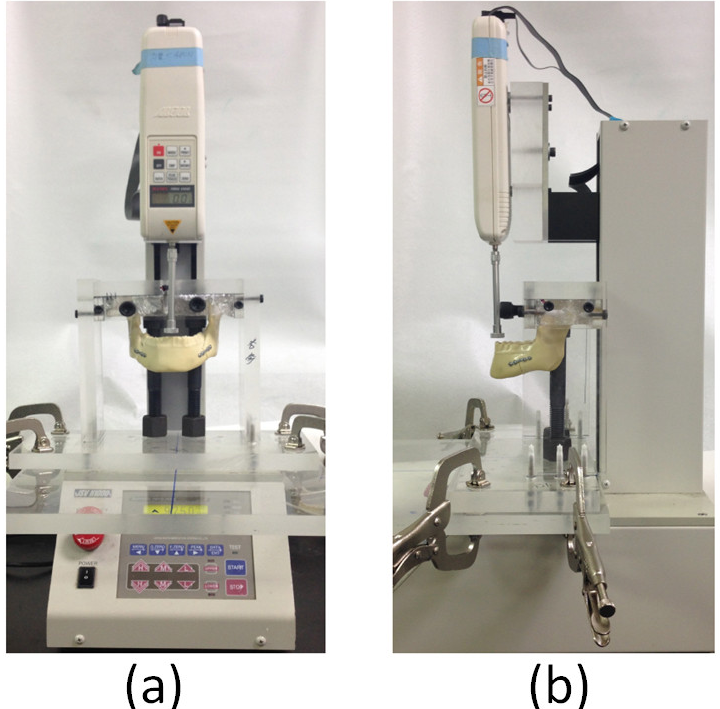
Figure 2. Artificial mandibular bone fixed to a supporting base for the biomechanical test: ( a ) frontal view; ( b ) side view.